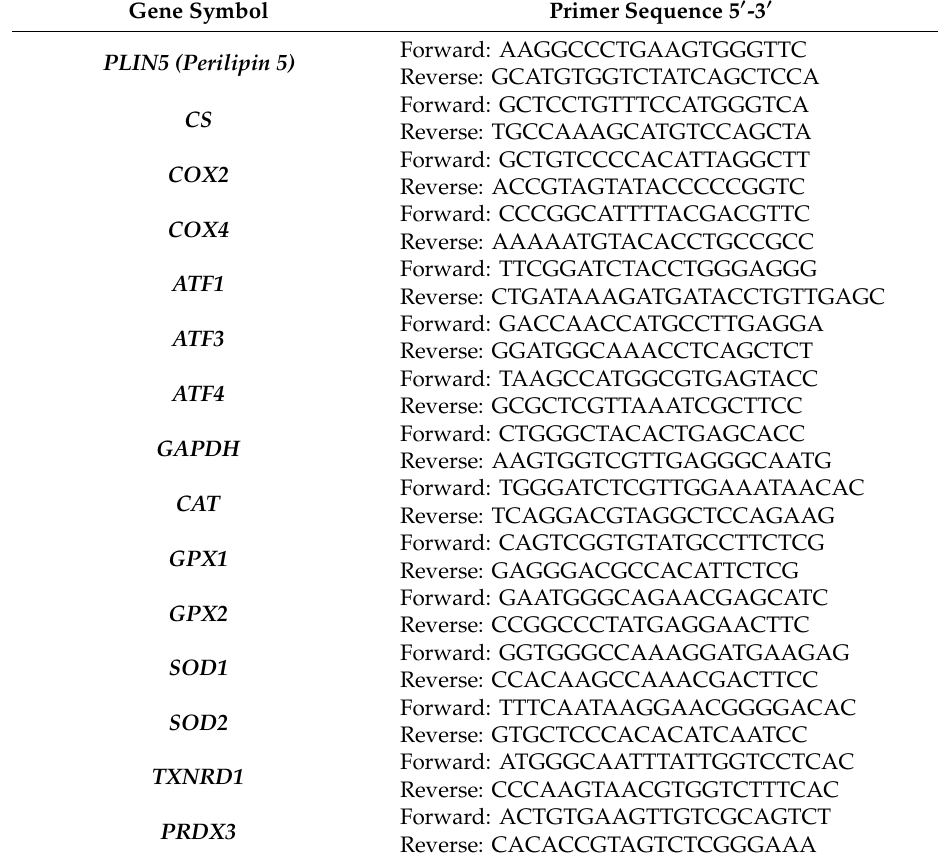
Table 1. Primer used for SYBR Green I qRT-PCR